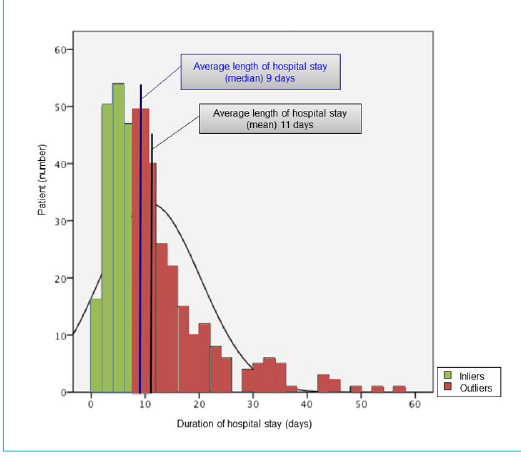
Figure 3: Number of hyponatraemic patients and their duration of in-hospital